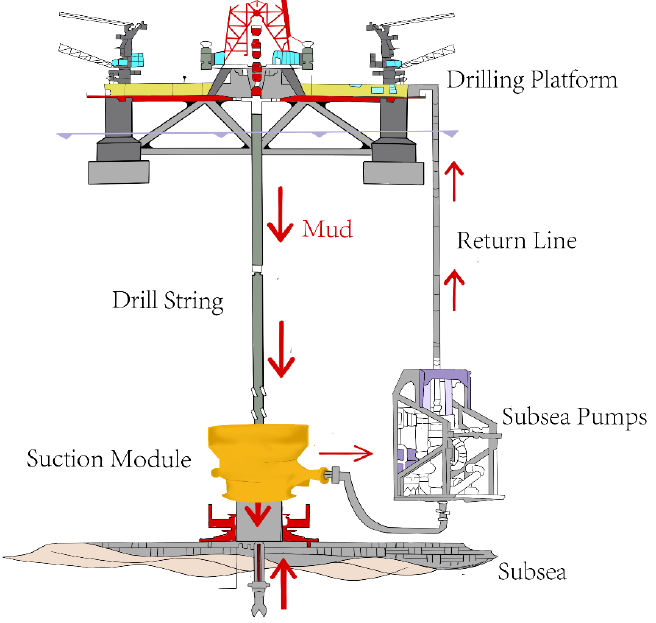
Figure 1. Schematic diagram of the structure of the RMR system.